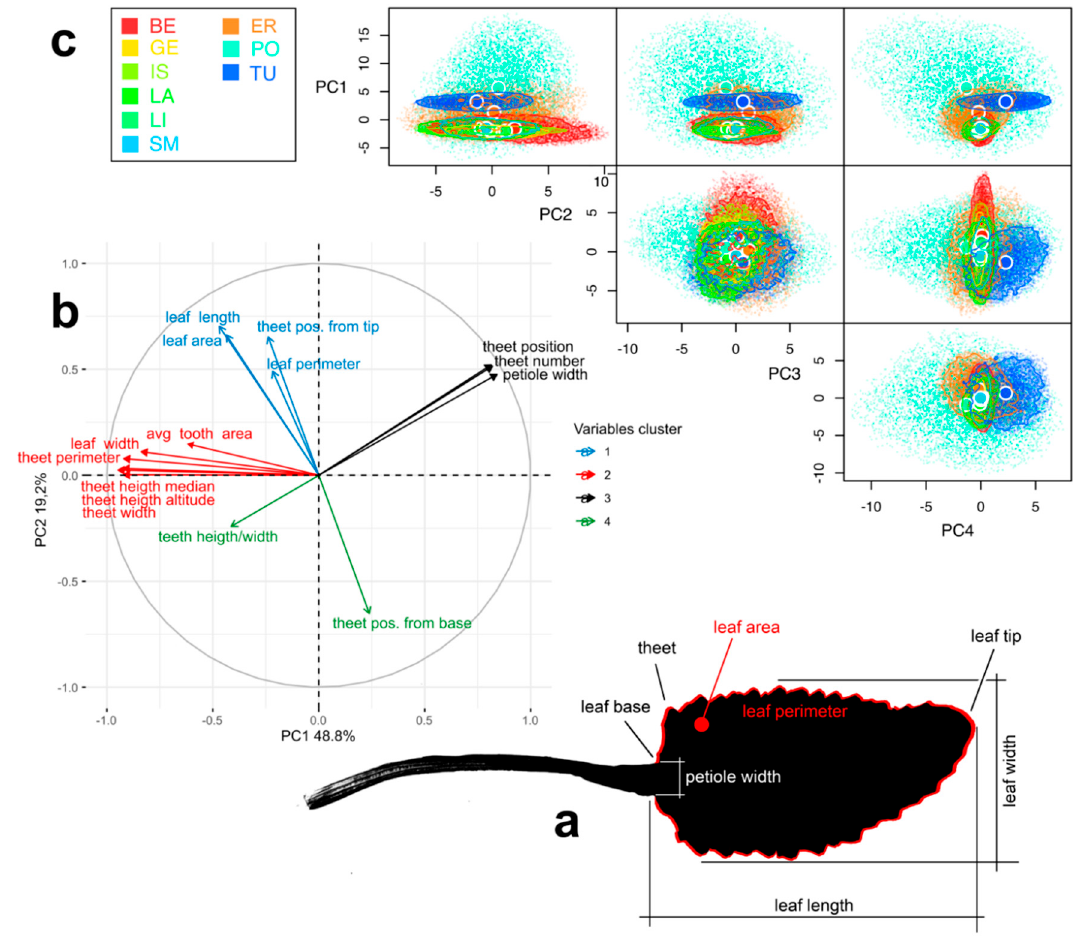
Figure 3. Leaf morphology: ( a ) Sketch of a Tephroseris balbisiana leaf and the main traits measured. ( b ) PCA on the 15 leaf morphology traits. Each of them is represented as eigenvector and clusterized with k-means analysis based on correlations. ( c ) Pair plots representing the 4-dimensional hypervolumes for each of the nine populations of T. balbisiana . For each hypervolume, 5000 stochastic points are shown.